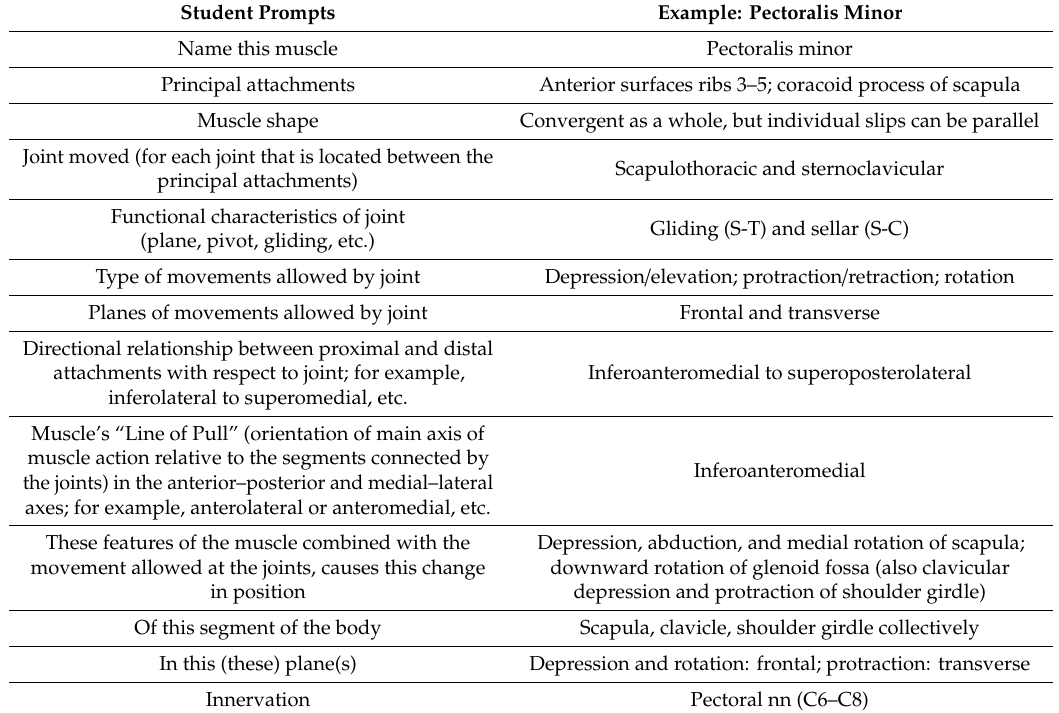
Table 2. Template for describing